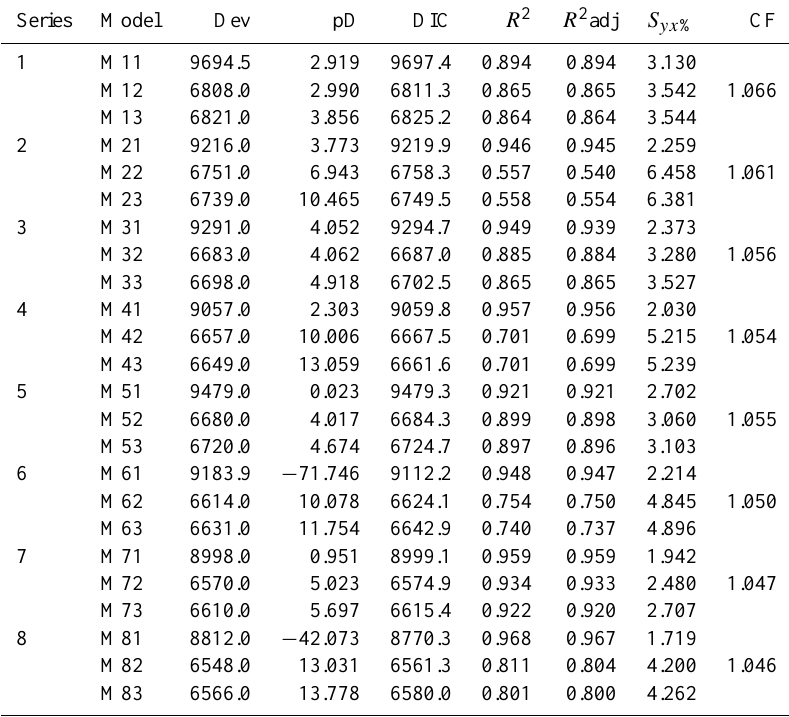
Table 3. Statistics of aboveground biomass (AGB) estimation models fit in a terra firme forest near Manaus, Amazonas, Brazil. See Table 2 for predictors and applied variance modeling approaches and Table A3 for the models’